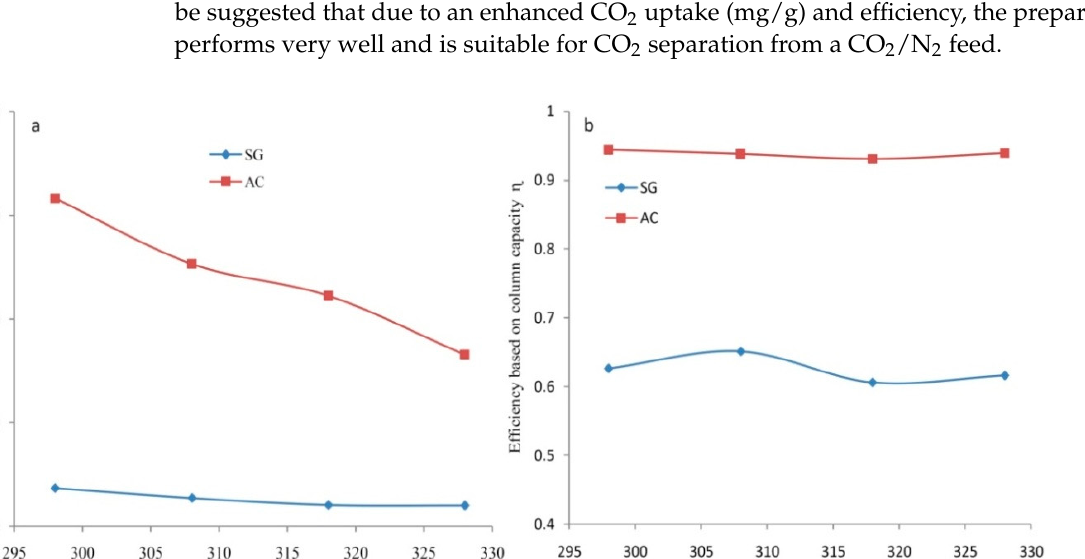
CO 2 uptake of 73.1 mg/g was determined for AC at 298 K with 5 lpm. The lowest feed flow of 2 lpm contributed to a minimal adsorption capacity and a CO 2 uptake of 6.43 mg/g was obtained for the SG at a temperature of 298 K and C o = 5%. The adsorption performance of the prepared activated carbon was reasonably higher at any fixed feed flow rate. The produced activated carbon contributed to a higher effective column efficiency. The effi- ciency based on column capacity determined at different flow rates is depicted in Figure 12b for SG and AC. Moreover, the efficiency obtained in the case of the synthesized carbon was considerably greater with a maximal value of 0.94 at 2 lpm or 3 lpm with 298 K and C o = 5%. The highest fraction of the total capacity effectively used was 0.73 for SG with a feed flow of 2 lpm under the same conditions of temperature and initial adsorbable gas level. The average value of η = 0.94 determined for the produced carbon was considerably higher than that realized for other adsorbents (average η = 0.65). In general, it is seen that the effective column efficiency decreased marginally with an increased feed flow of 2 to 5 slpm. Significantly, the higher efficiency of AC dictates its suitability for economical CO 2 separation from a CO 2 /N 2 mixture. It can be predicted that an effective column efficiency varies negatively with augmented feed flow rates. It can be suggested that developed ac- tivated carbon performs very well and is suitable for CO 2 separation from a CO 2 /N 2 feed.